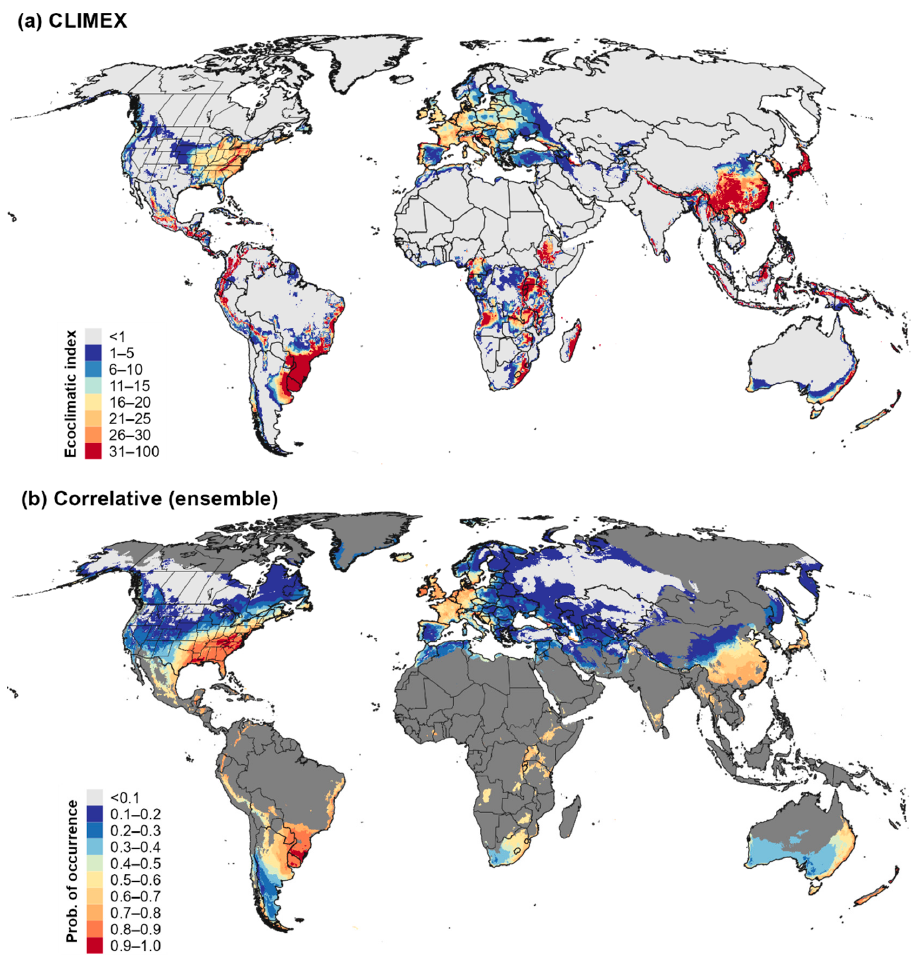
Figure 8. Climatic suitability for Calonectria pseudonaviculata globally. Climatic suitability is estimated as the ecoclimatic index in the ( a ) CLIMEX model, and as the probability of occurrence in the ( b ) ensemble correlative model. Areas with relatively high levels of climatic dissimilarity to the model calibration area (MOP values <0.9) are shown in dark gray in the correlative ensemble model.